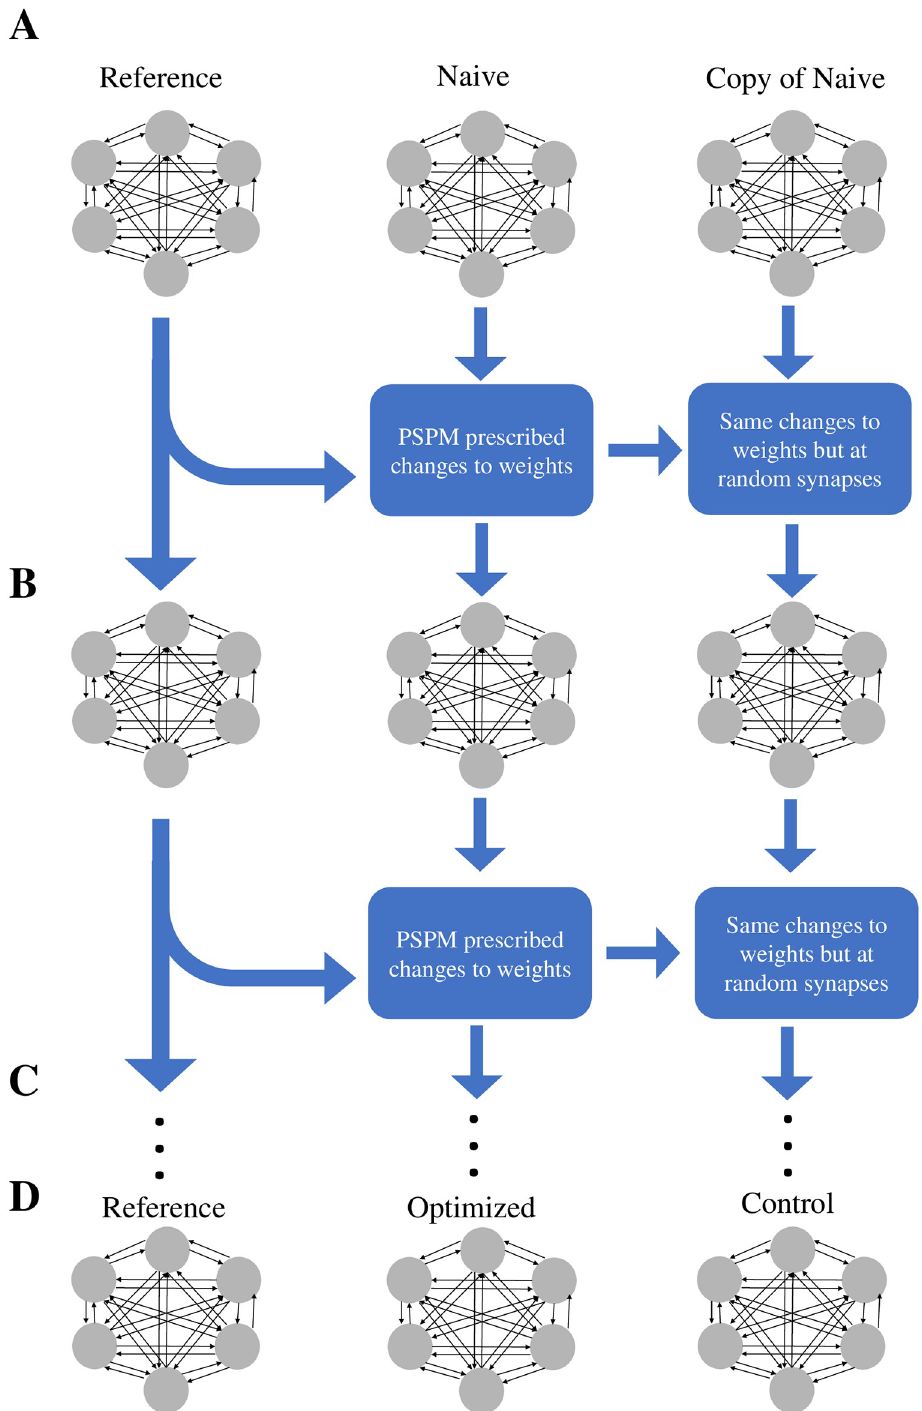
Fig 1. Learning Paradigm ( A ) Three networks are initialized: The reference network, a naive network and its copy. In addition, a set of input currents is generated and will be used throughout the trial. When simulated, the reference network produces goal spike trains R that the learning rule aims to reproduce in the optimized network. A naive network and its identical copy are created with weights distinct from the reference. ( B ) The reference and naive networks are simulated with the same input currents to generate outputs R and N and the PSPM learning rules are followed to change the weights of the naive network, henceforth denoted as the pre-optimized network (middle